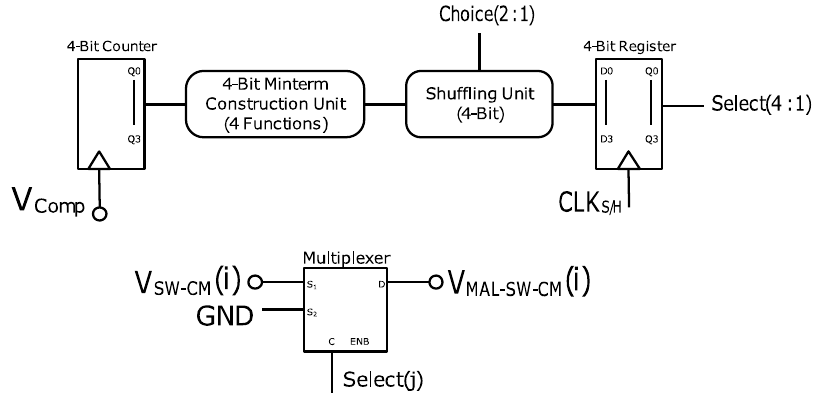
Figure 53. The circuit for the control ‐ path ‐ based attack.